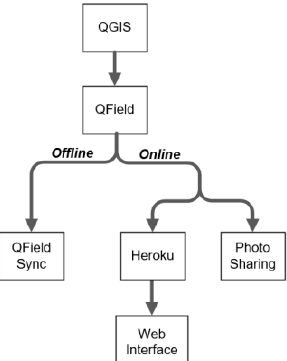
Figure 3 . Overall view of the educational